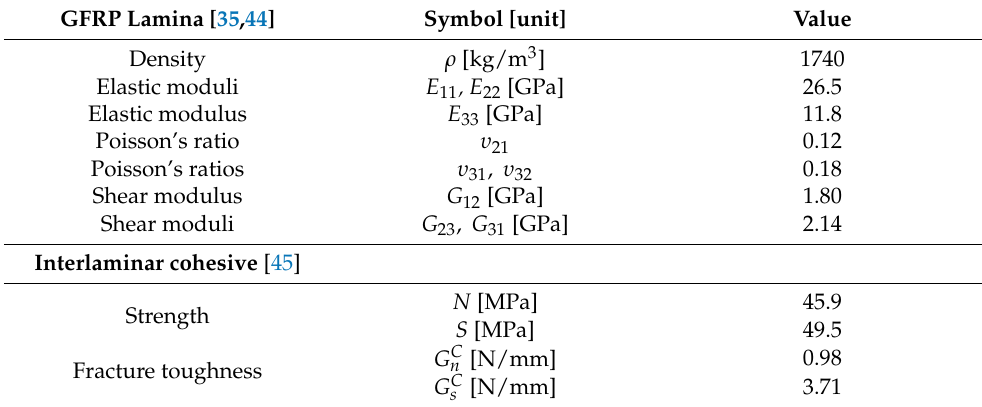
Table 1. The mechanical properties used for the GFRP plies [35,44] and the interlaminar cohesive elements [45].